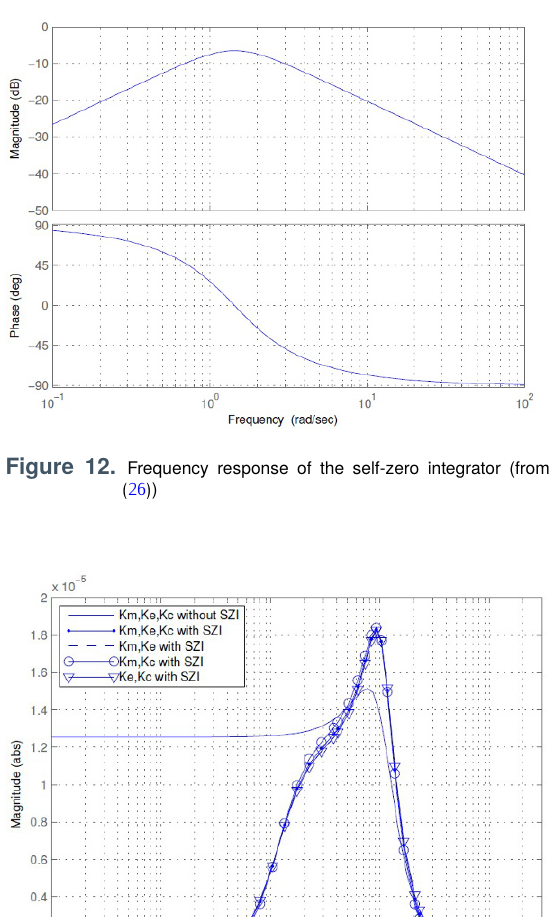
be studied depending on the fault scenario. For